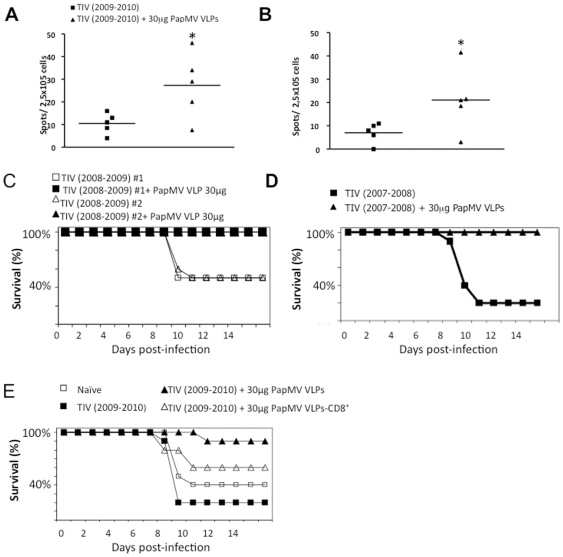
PapMV nanoparticles trigger a CTL response to conserved influenza epitopes.Balb/C mice (5 per group) were immunized twice with a 14-day interval with 1/5 of the human dose of TIV (2009–2010) alone or with 30 µg of PapMV nanoparticles. Spleens were collected 14 days after the boost. We used purified recombinant GST-NP (A) or GST-M1 protein derived from the WSN/33 strain (B) to perform an ELISPOT assay. * P <0.05. (C) PapMV nanoparticles improve survival to a sub-lethal challenge with a heterosubtypic strain. Balb/C mice (10 per group) were immunized with TIV (2008–2009) from two different companies (#1 or 2) alone or with 30 µg of PapMV nanoparticles. Mice were challenged with 1LD50 of A(H1N1)/WSN/33 influenza virus, 2 weeks after the final boost and were followed for a 14-day period. (D) A similar protocol was also followed with mice immunized once with TIV (2007–2008) alone or adjuvanted with 30 µg PapMV nanoparticles except that the infection with the heterosubtypic strain WSN/33 was performed 10 months after the immunization. (E) A immunization protocol similar to that described in c was performed with TIV (2008–2009) alone or adjuvanted with 30 µg of PapMV nanoparticles. The depletion of CD8+ cells was performed at days -3 and -1 before the challenge and 14 days after the boost.